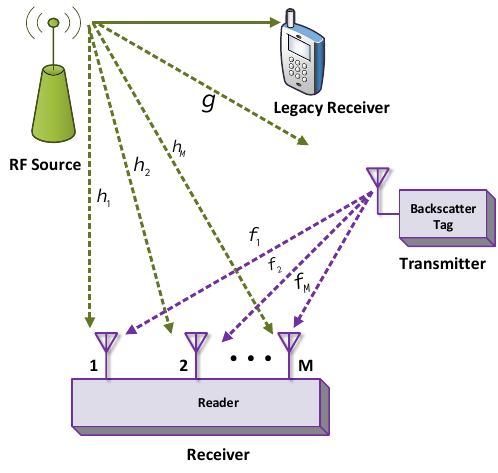
Figure 36. Multi-antenna in